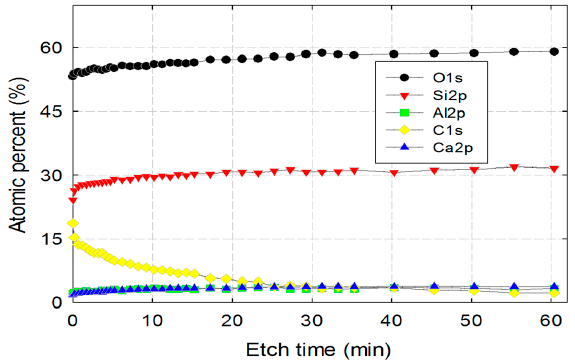
Figure 9. Depth profile of the gel formed from leachate at 70 °C.